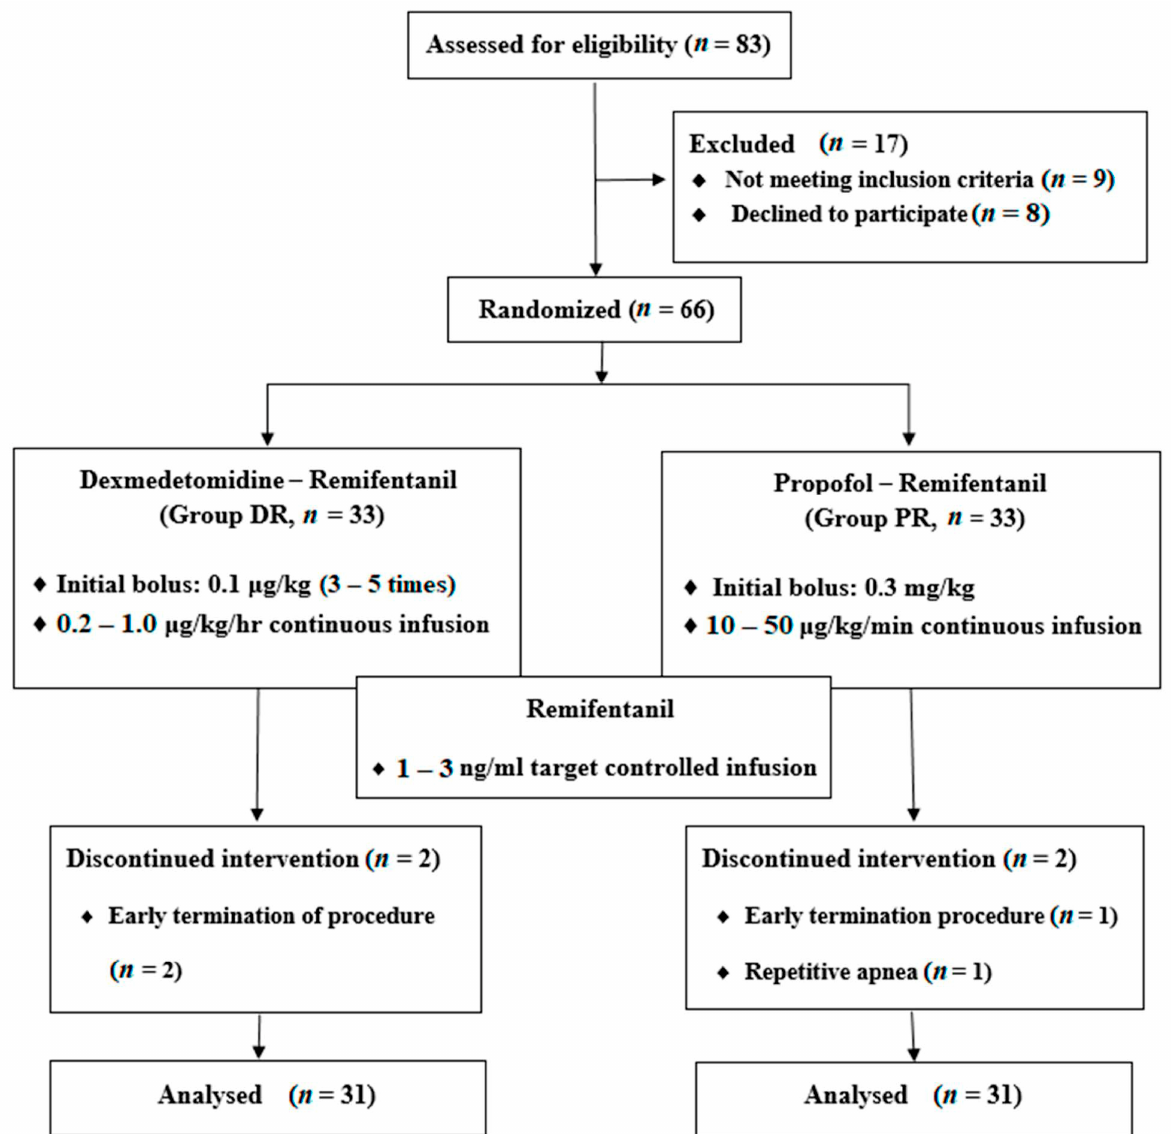
Figure 1. CONSORT flow diagram showing the study protocol and the patients’ progress through the study phases. Patient characteristics and operative data are shown in Table 1. There were no signifi- cant differences in demographic or technical details during RFA. Sedation and procedure- related outcomes are shown in Table